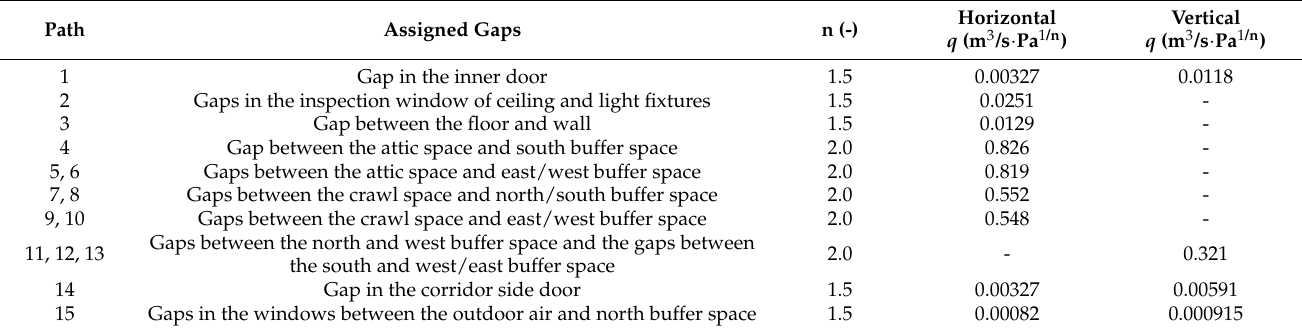
Figure 8. Schematic of the window gap. Table 5. Airflow paths and their flow characteristics.